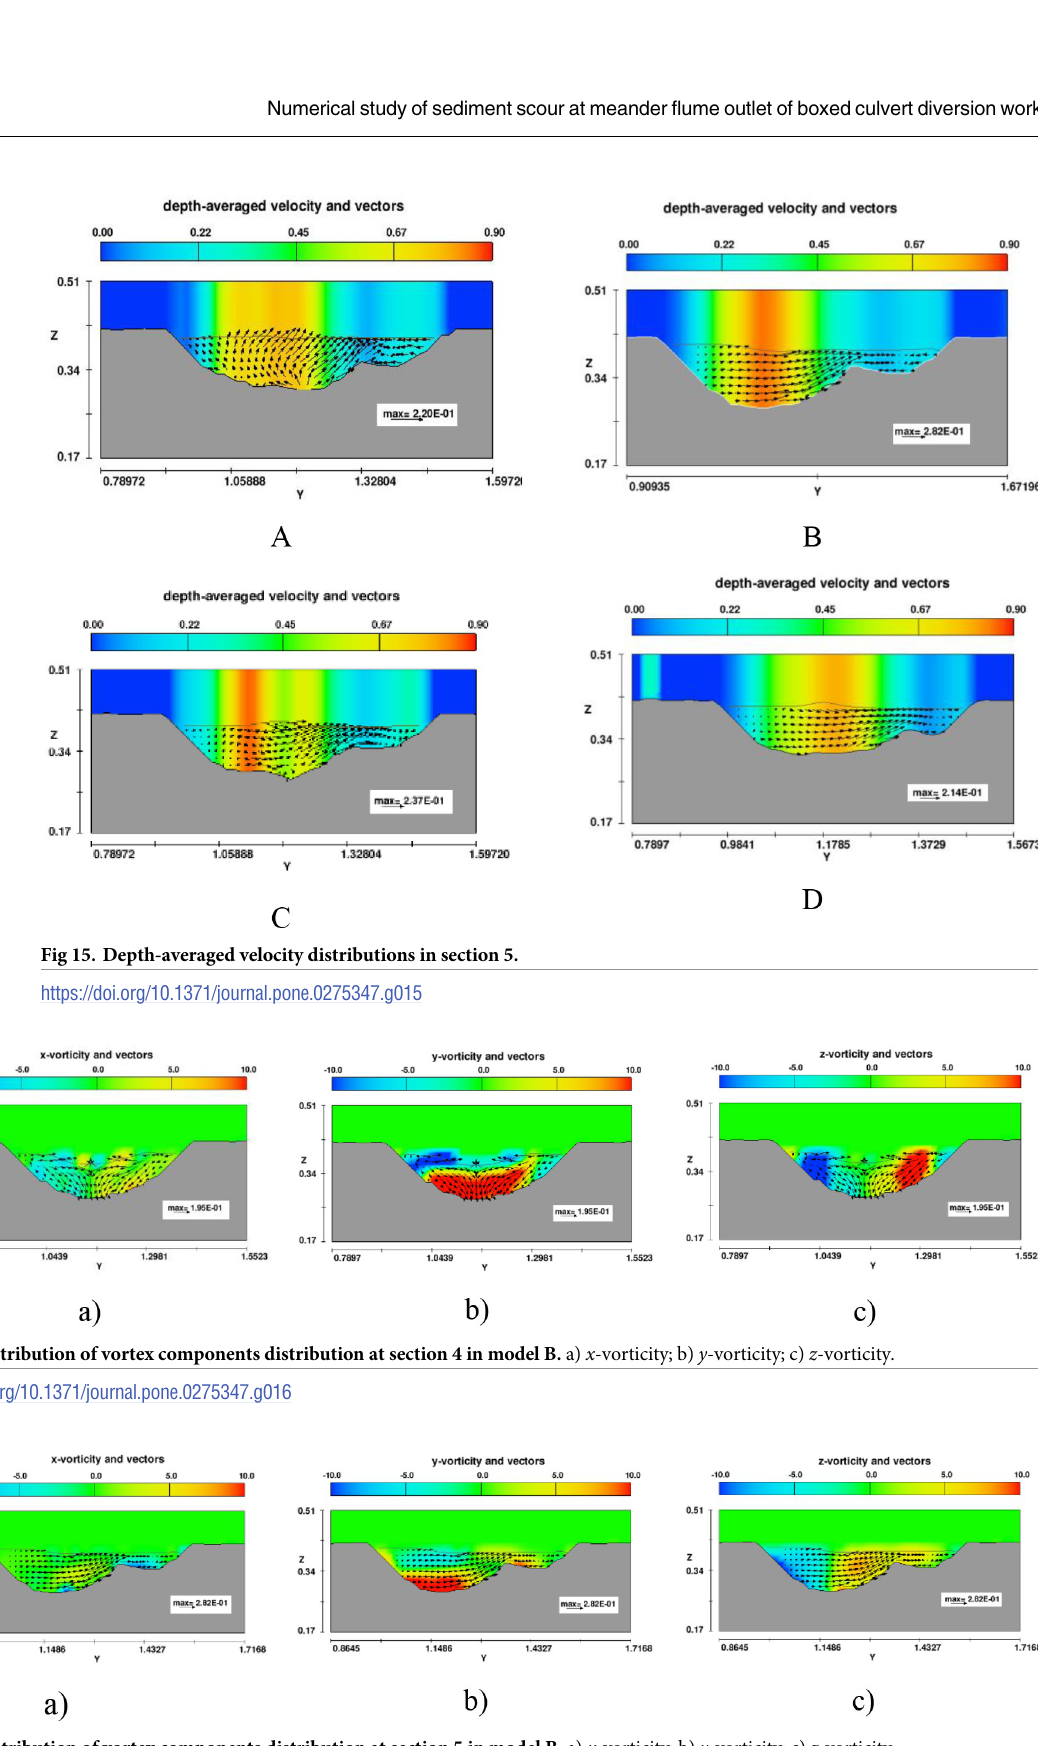
PLOS ONE | https://doi.org/10.1371/journal.pone.0275347 September 30,